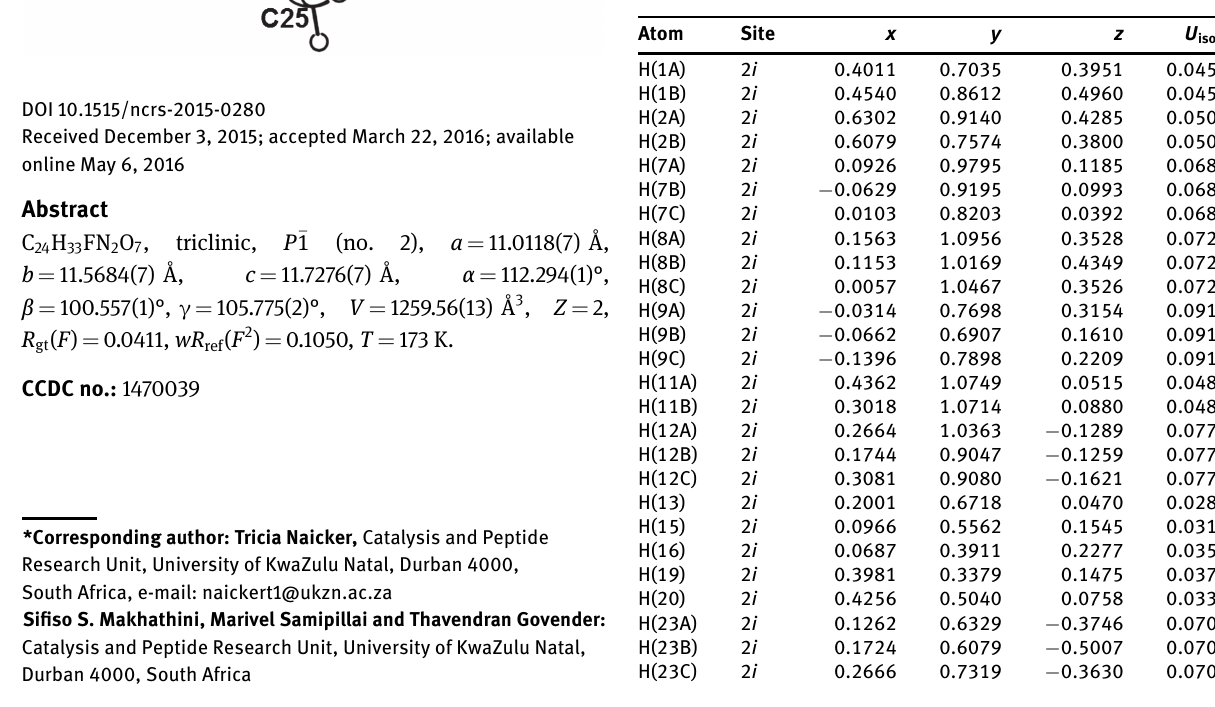
Table 2: Fractional atomic coordinates and isotropic or equivalent isotropic displacement parameters (Å 2